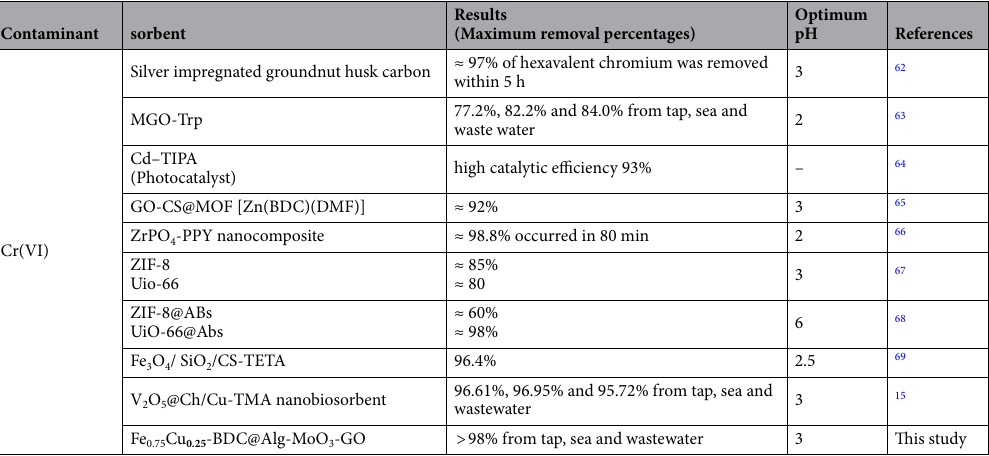
Table 5. Comparison of the maximum removal percentage of Cr(VI) by different